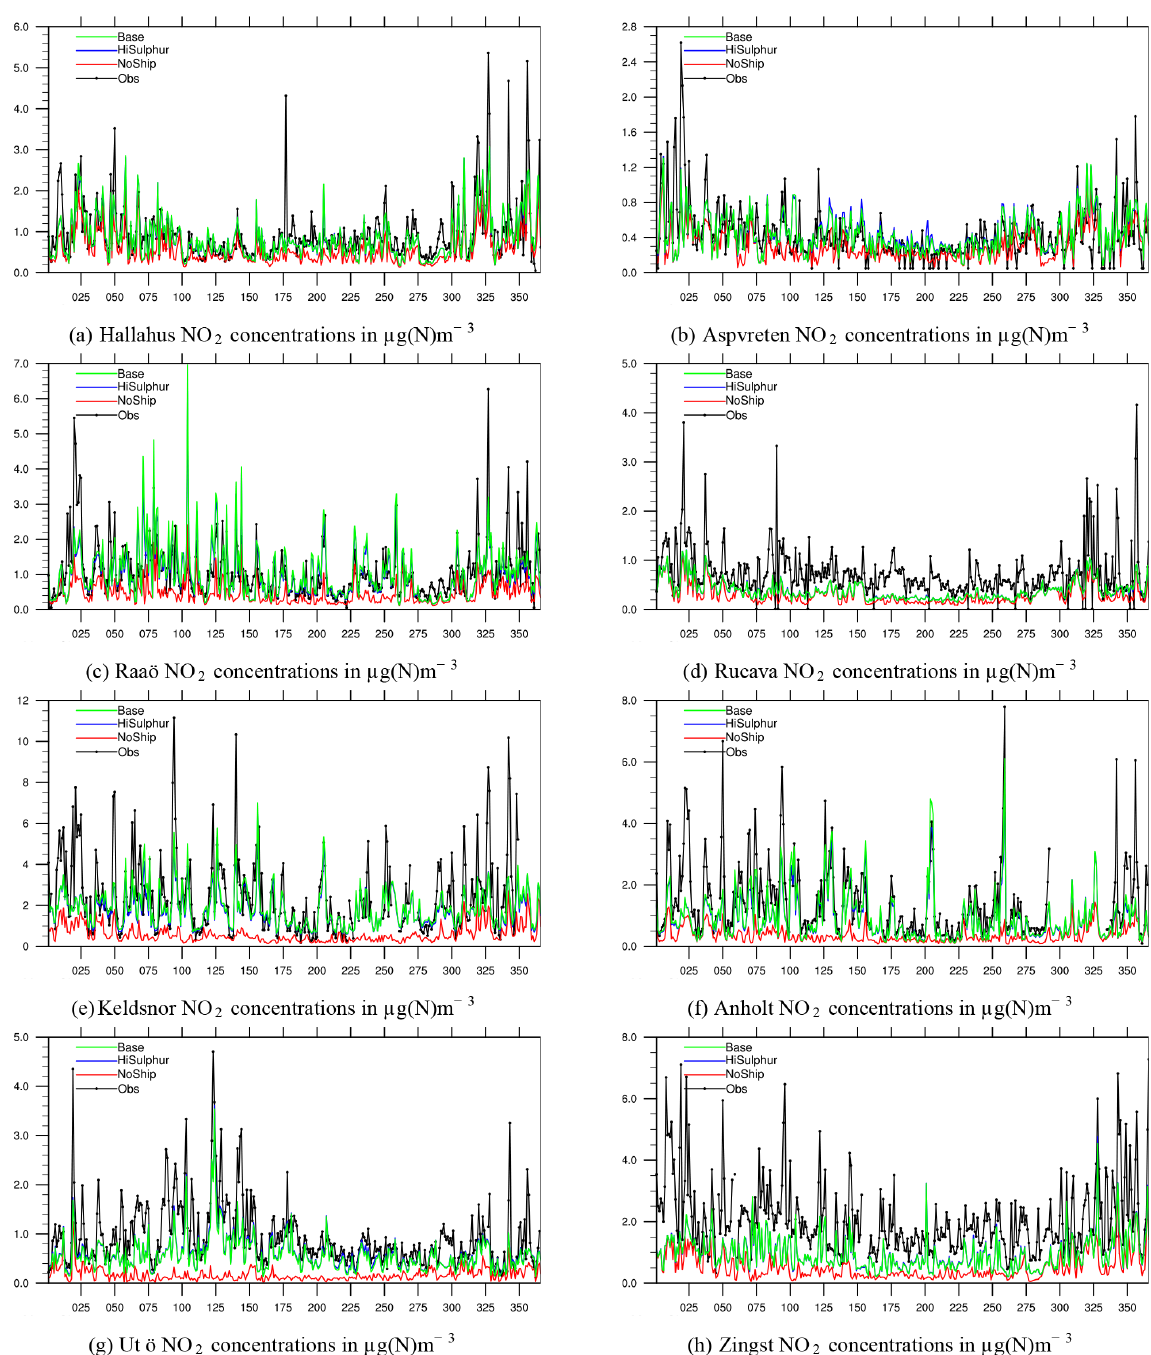
Figure A2. Measured and model-calculated present (2016) concentrations of NO 2 . Present model-calculated results are shown for the Base, HiSulphur, and NoShip scenarios. The HiSulphur calculations are not visible as they are almost identical to